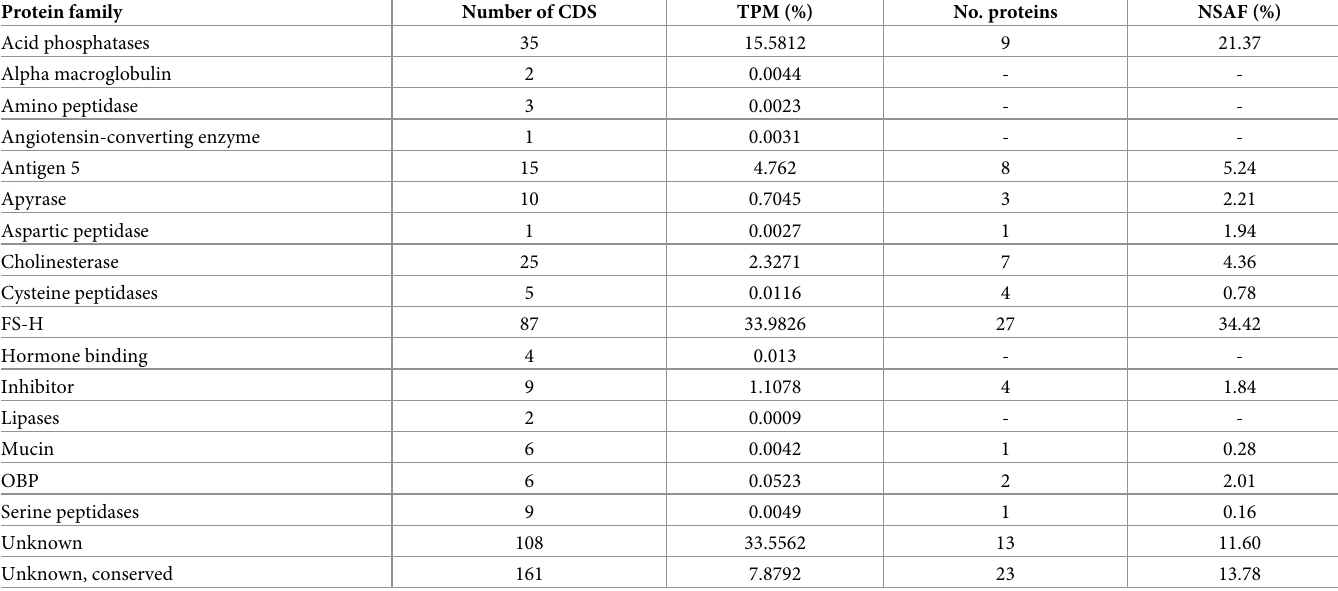
Table 2. Relative abundance of protein families found within the ‘secreted’ functional